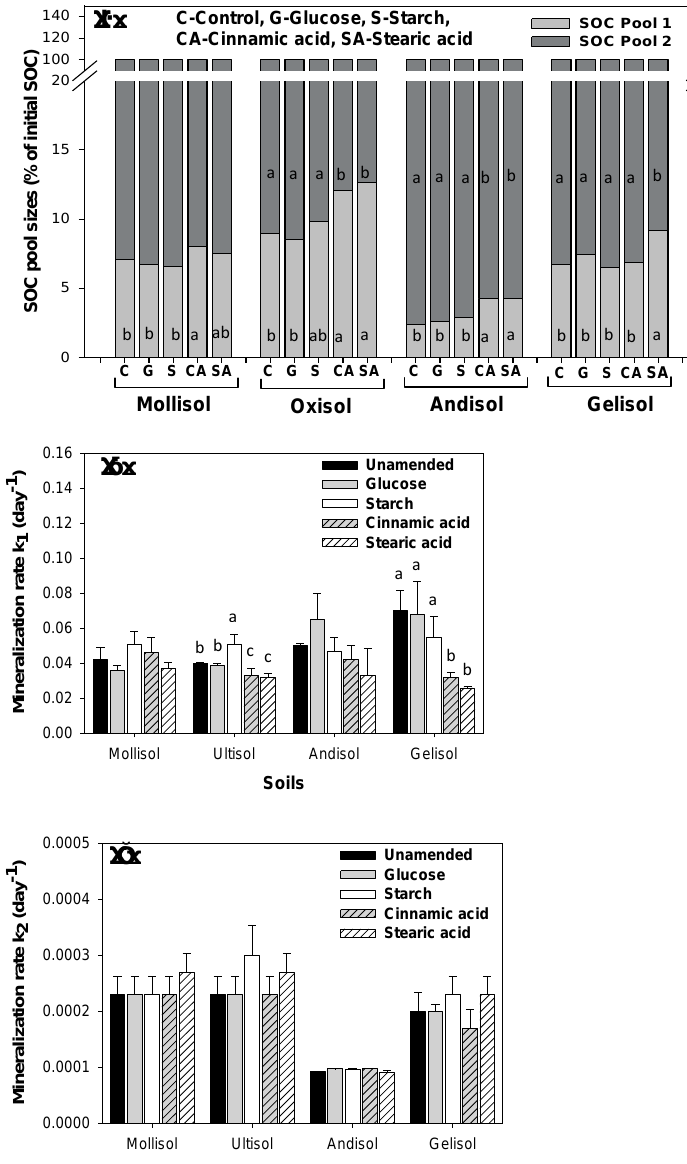
Figure 4. Effect of substrate types on native soil organic carbon mineralization parameters: pool sizes (a) , mineralization rate k 1 associated with Pool 1 (b) , and mineralization rate k 2 associated with Pool 2 (c) . Lower-case letters on bar segments in (a) and on top of bars in (b) represent statistical significance at P < 0 . 05. No letters mean statistical